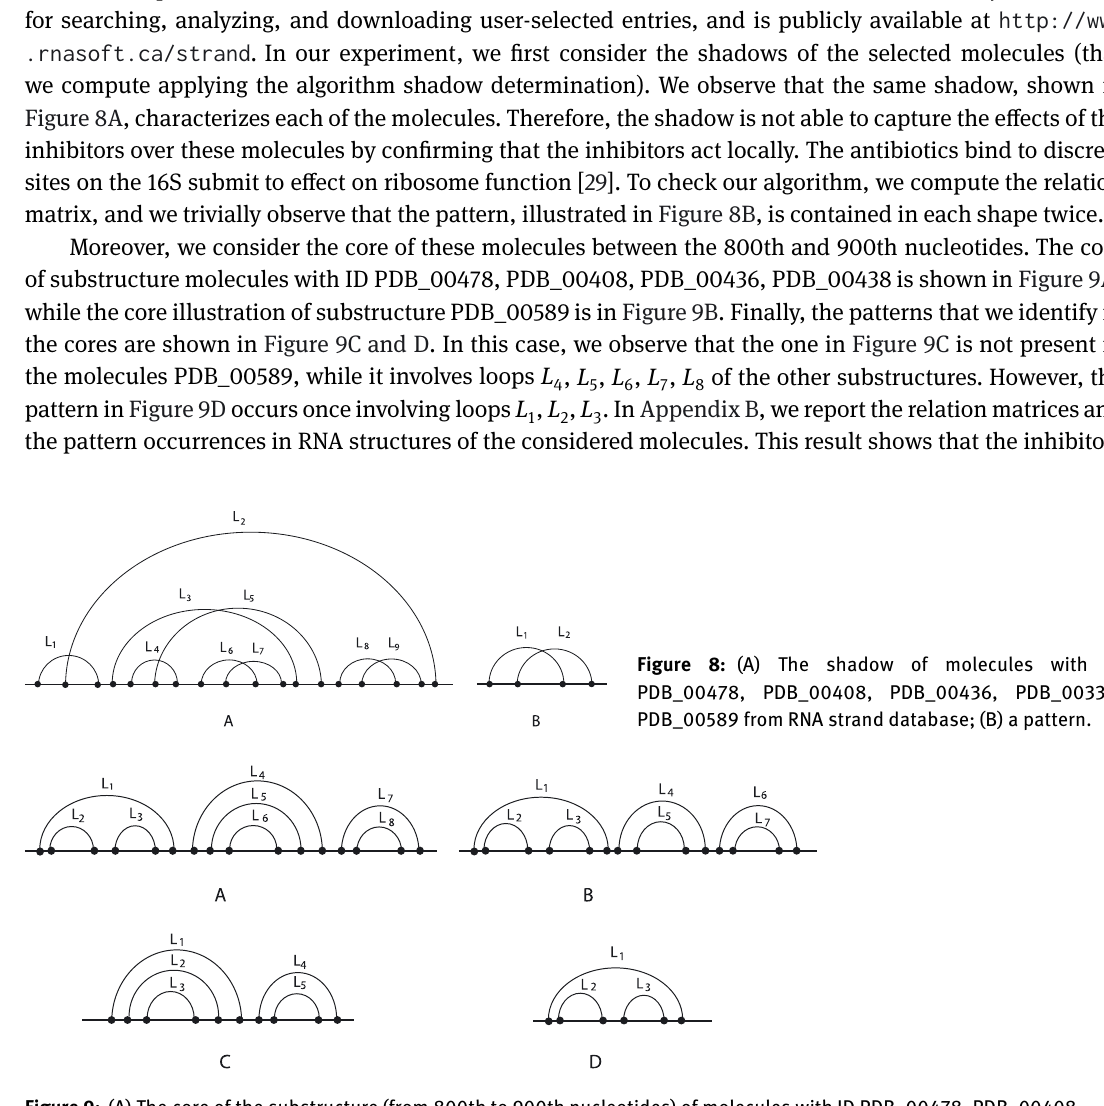
Figure 9: (A) The core of the substructure (from 800th to 900th nucleotides) of molecules with ID PDB_00478, PDB_00408, PDB_00436, PDB_00338 from RNA strand database; (B) the core of the substructure (from 800th to 900th nucleotides) of molecules ID PDB_00589; (C) and (D) two